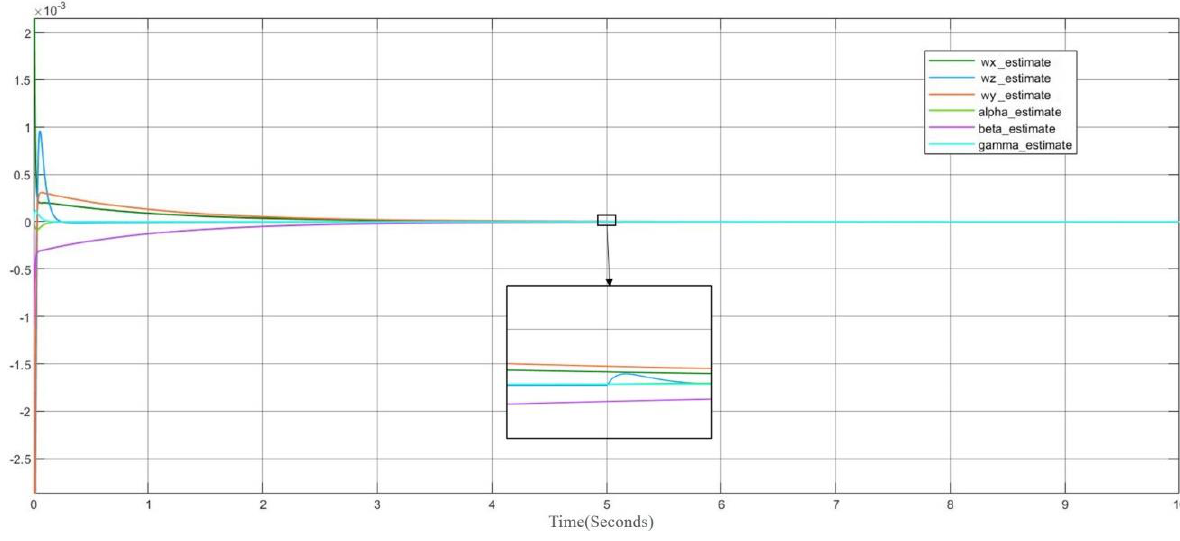
Figure 10. Input 2’s 40% PLOE fault detection simulation.